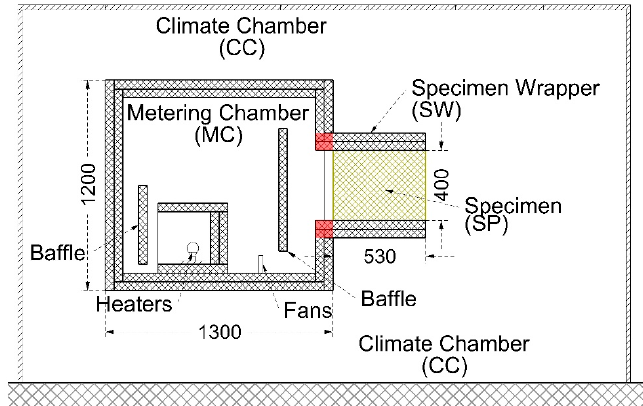
Figure 1. Sketch of a vertical section of the system.